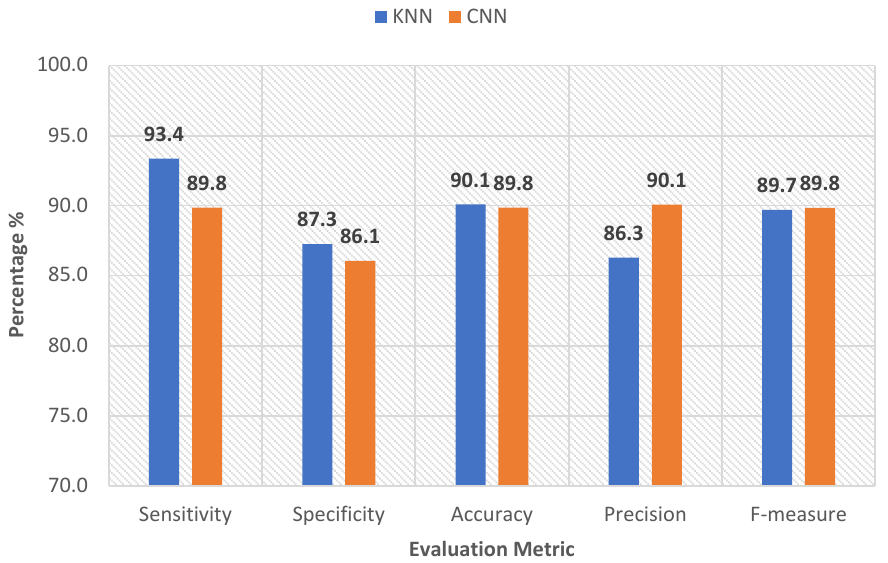
Figure 6. Evaluation metrics of the CNN and k NN classifiers (left side).